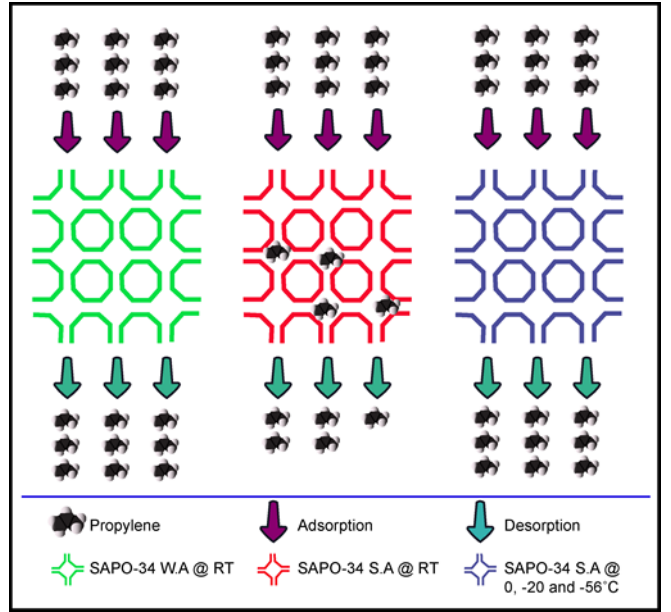
Figure 5. Schematic presentation of propene adsorption and chemisorption on SAPO-34 zeolites with various acidic strengths at different temperatures .